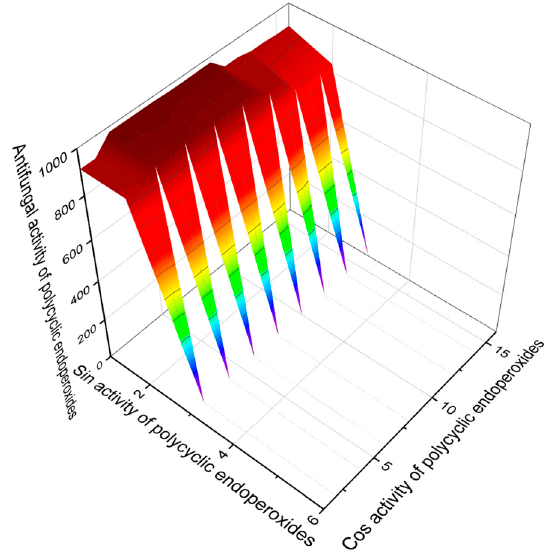
Figure 16. The 3D graph shows the predicted and calculated antifungal activity of selected polycyclic endoperoxides (compound numbers: 86 , 87 , 88 , 89 , 90 , 91 , 92 , 138 , and 139 ) polycyclic endoperoxides showing the highest degree of confidence, more than 95%.